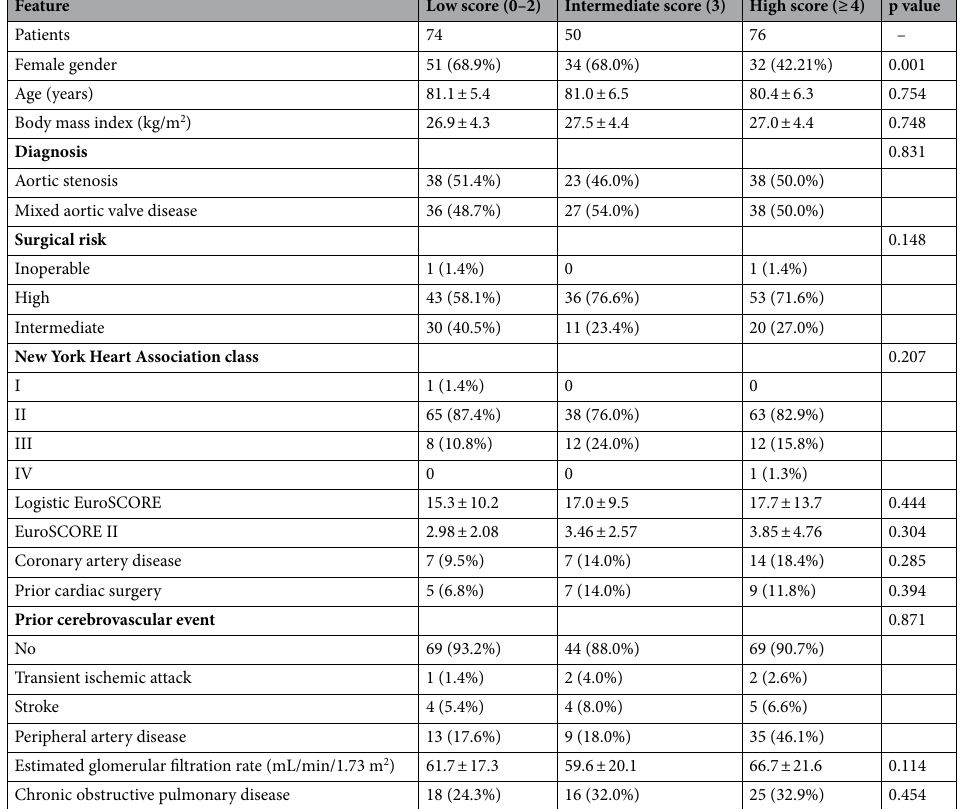
Table 1. Baseline features according to TAVI-CT (transcatheter aortic valve implantation-computed tomography)